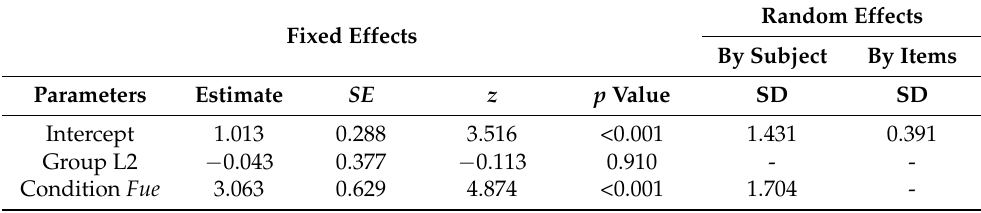
Table 6. Parameter estimates for HL and L2 learners’ accuracy with grammatical passives with era and fue.